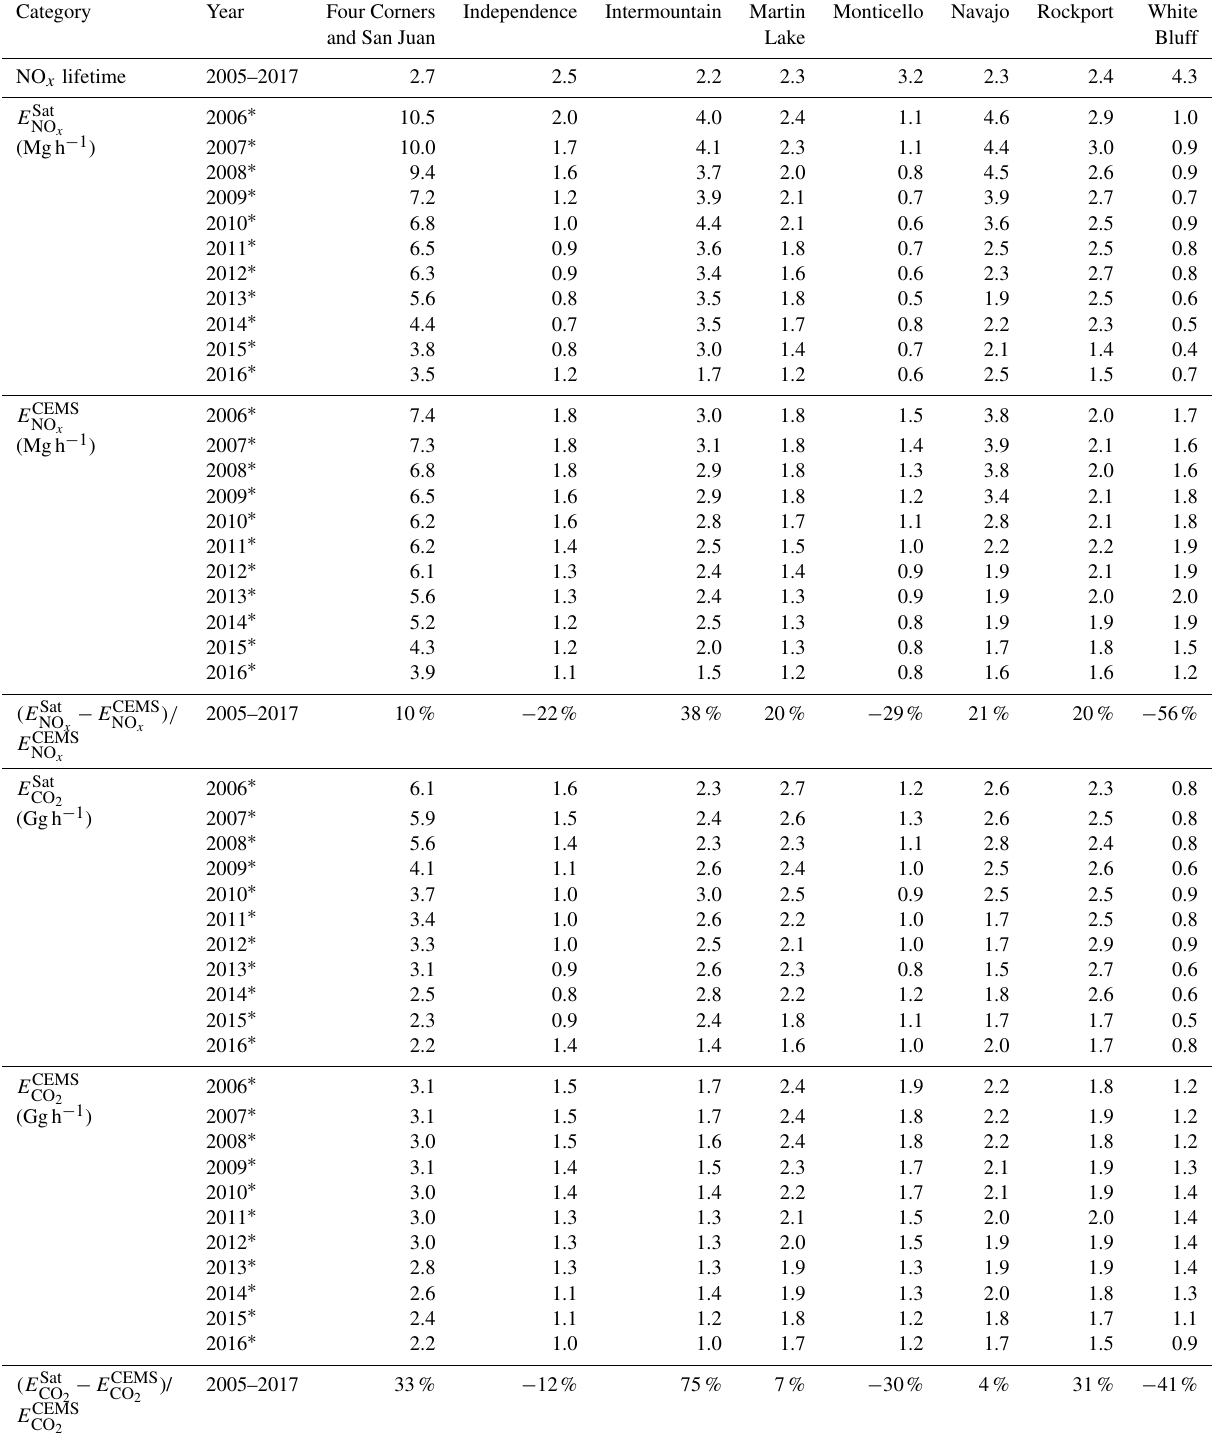
Table 2. Summary of effective NO x lifetimes, satellite-derived NO x emissions ( E Sat sions ( E CEMS ), and CO 2 emissions ( E CEMS ) for eight US power plants during May to September from 2005 to 2017. The 3-year periods NO x CO 2 are represented by the middle year with an